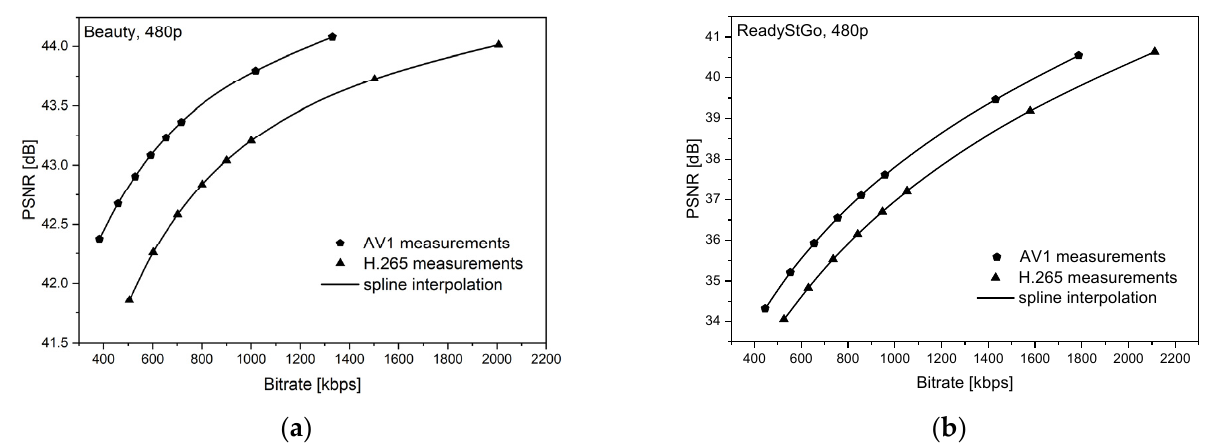
Figure 8. Comparison of the H.265 and AV1 codecs, based on the PSNR metric, for two different videos: ( a ) slow motion video; ( b ) fast motion video.